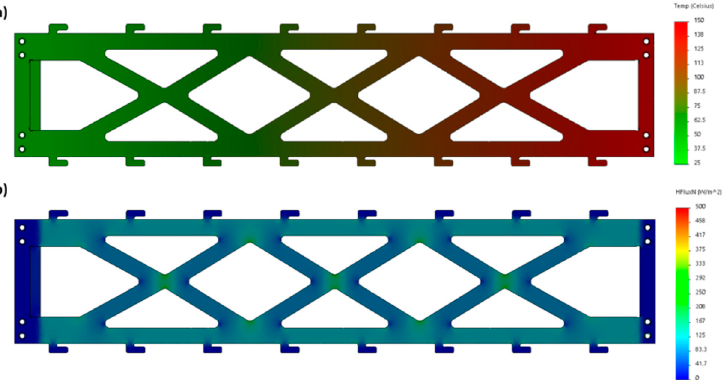
Figure 10. Thermal analysis of the outer epoxy support when the large clutch is at 150 °C. ( a ) A temperature map and ( b ) the heat flux. The power transferred in this simulation was about 0.015 W.